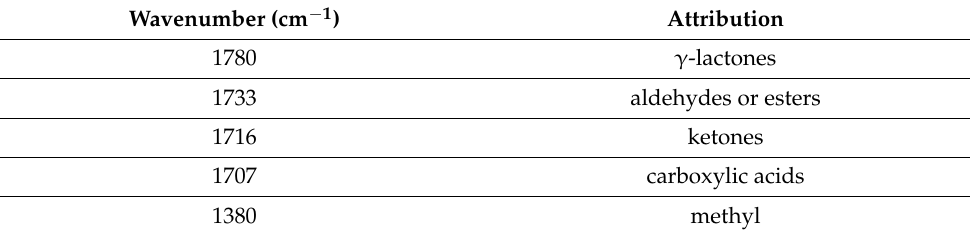
Figure 6. FT-IR spectra under different UV irradiation times. ( a ) LLDPE film; ( b ) PE-0.9 film. Table 4. Vibrational peaks in infrared spectra and their attribution.